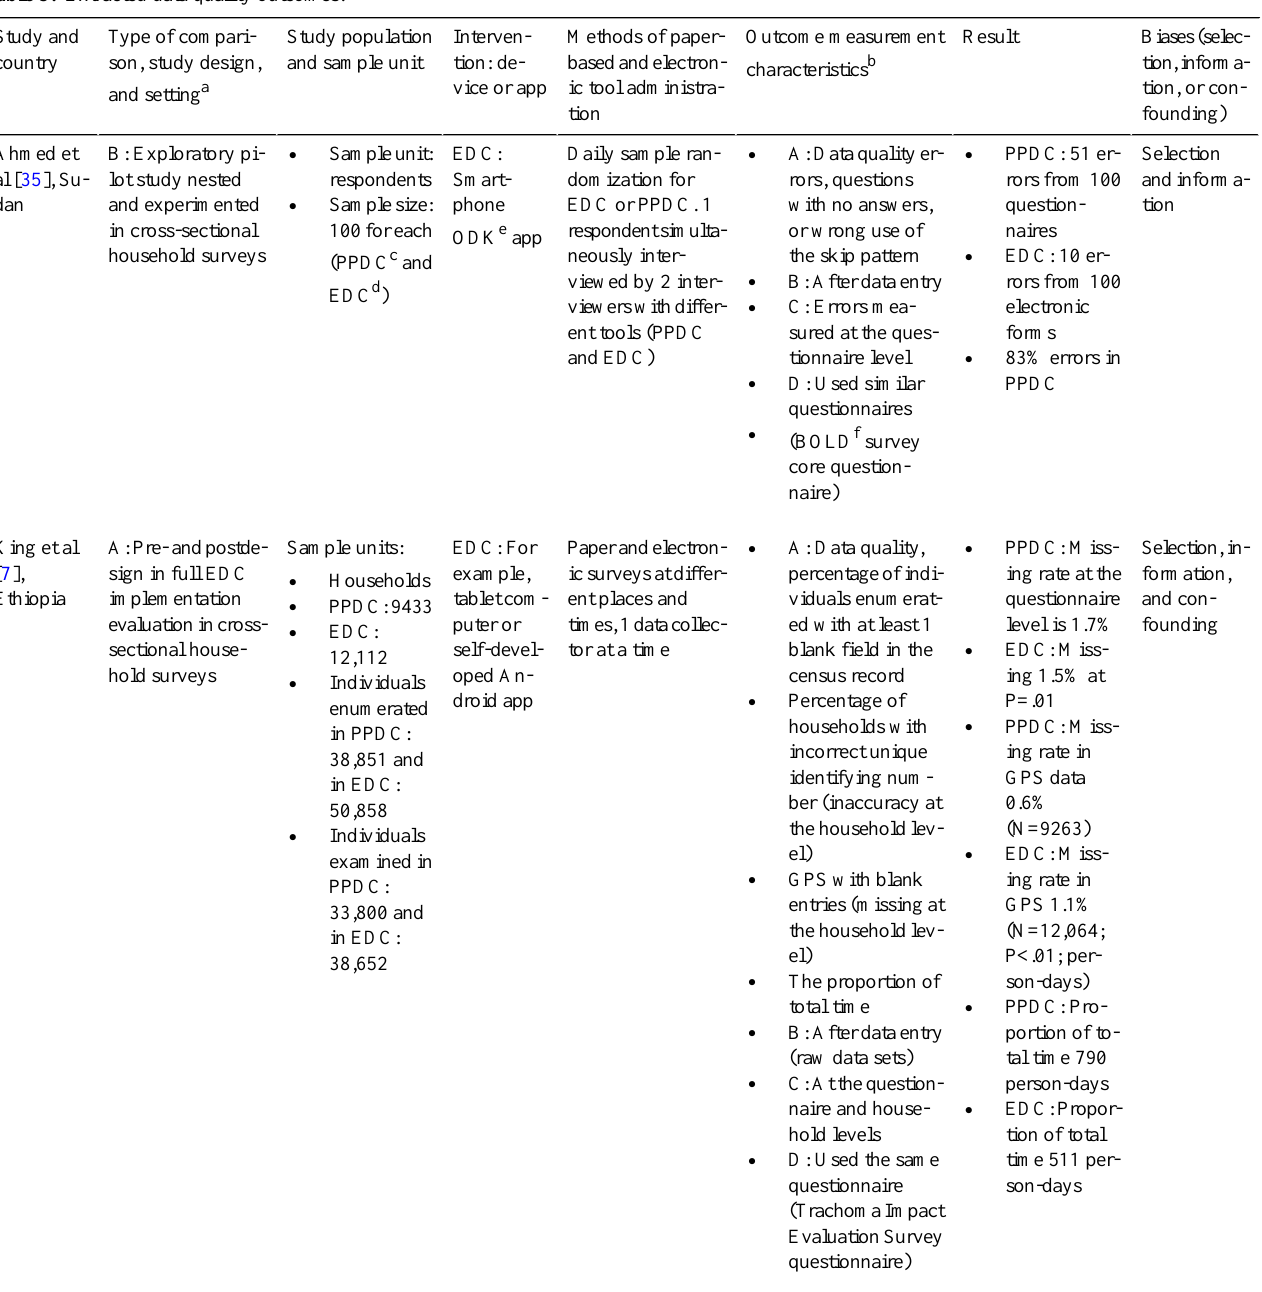
Table 3. Extracted data quality